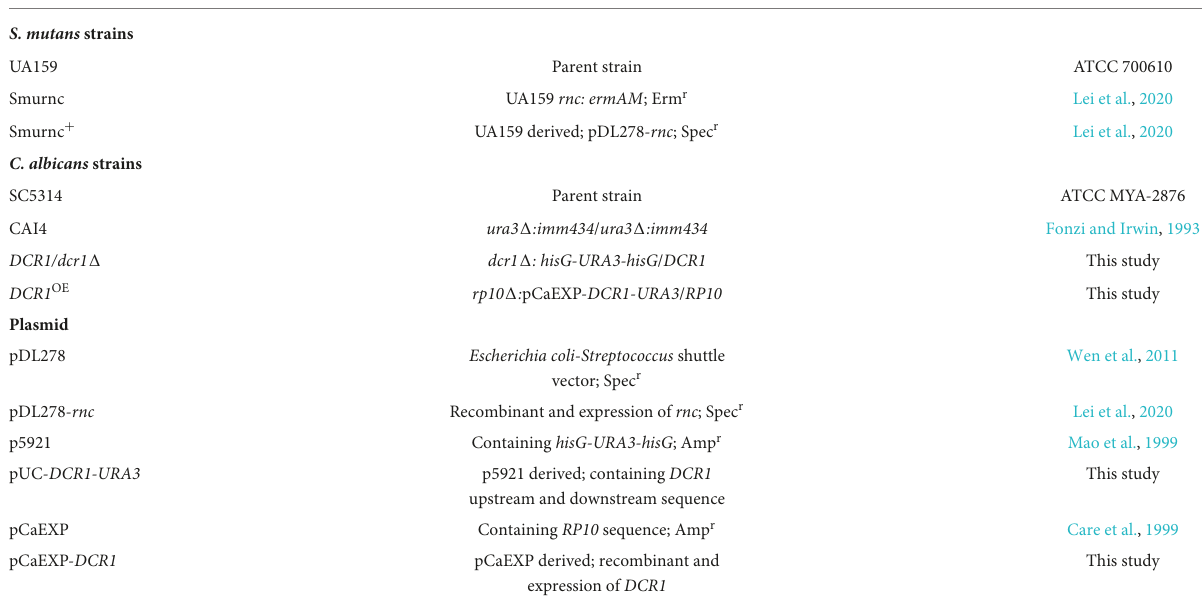
TABLE 1 Microbial strains and plasmid used in this study.